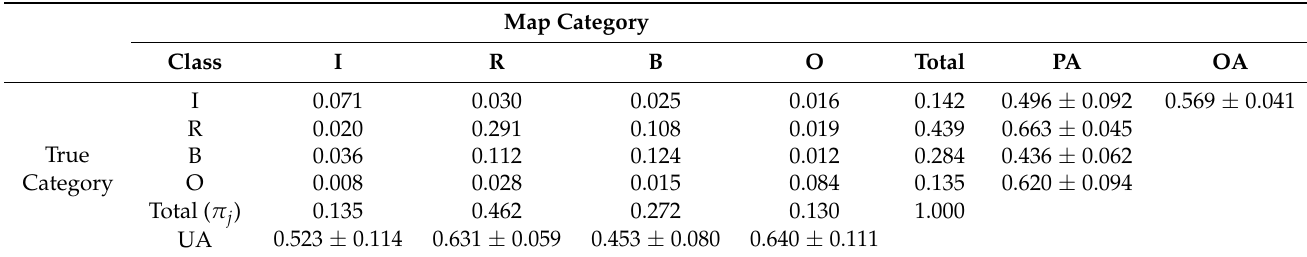
Table 6. Confusion matrix of FI-based classification results (I: Institution; R: Residence; B: Business; O: Open Space). UA: users accuracy; PA: producers accuracy; OA: overall accuracy; π _j is the class proportion according to the classified